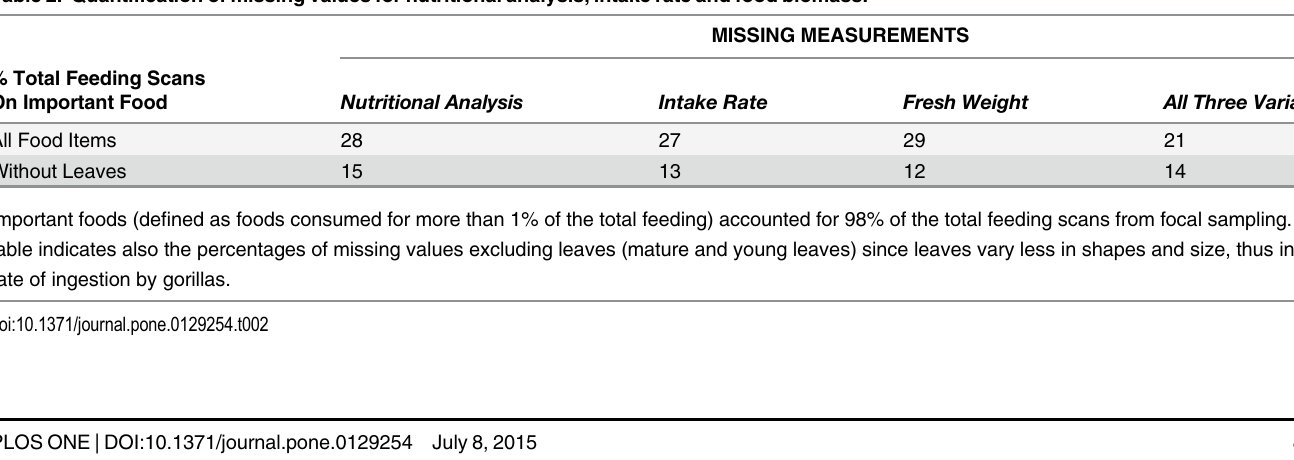
Table 2. Quantification of missing values for nutritional analysis, intake rate and food